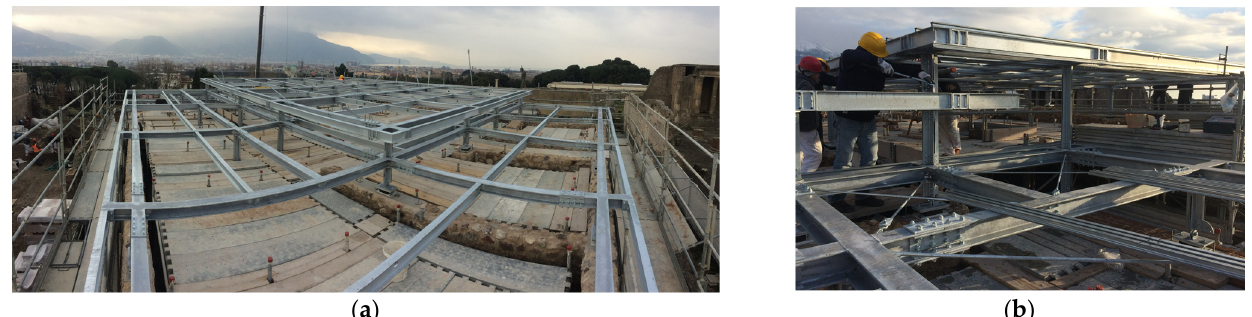
Figure 15. ( a ) Steel beams during structural work. ( b ) Details under construction.